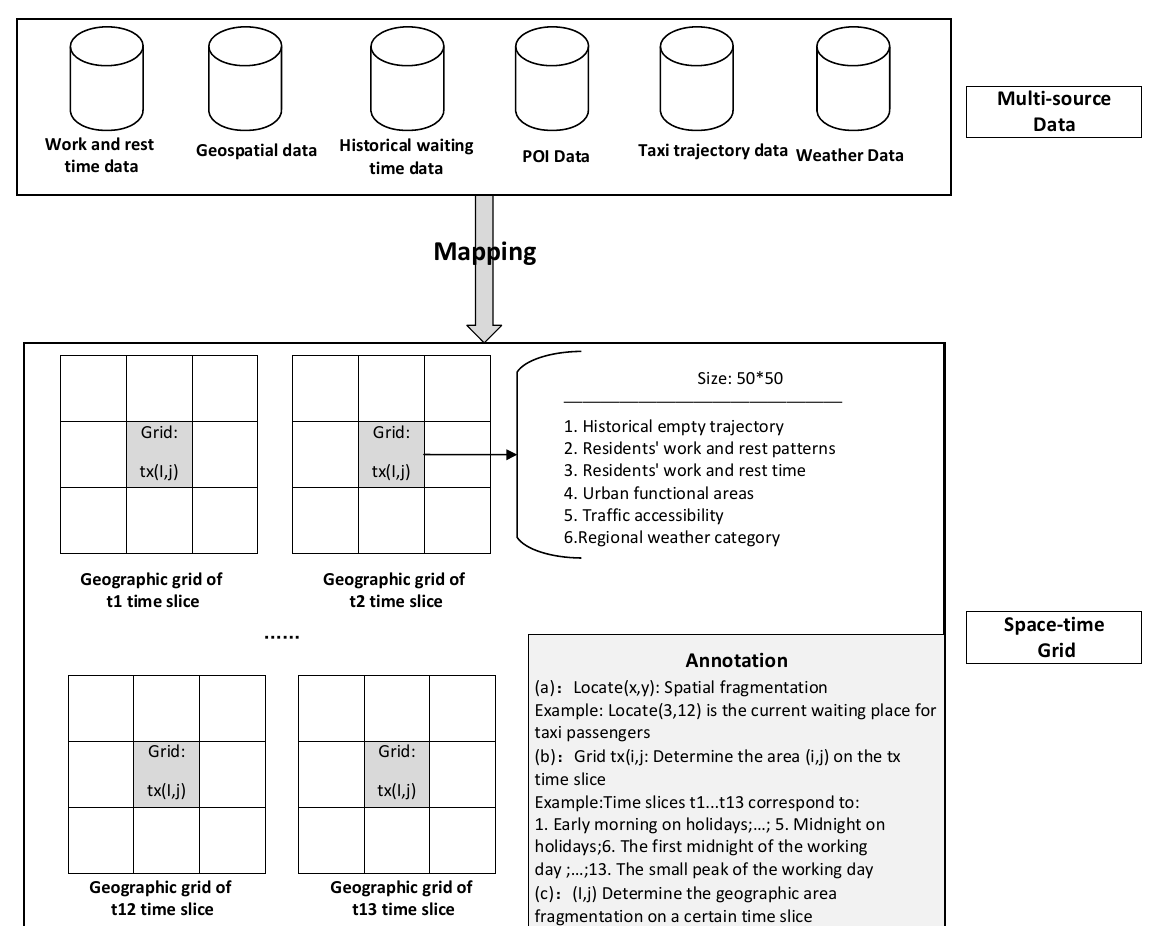
9 of 21 Figure 3. Multi ‐ source data fusion.